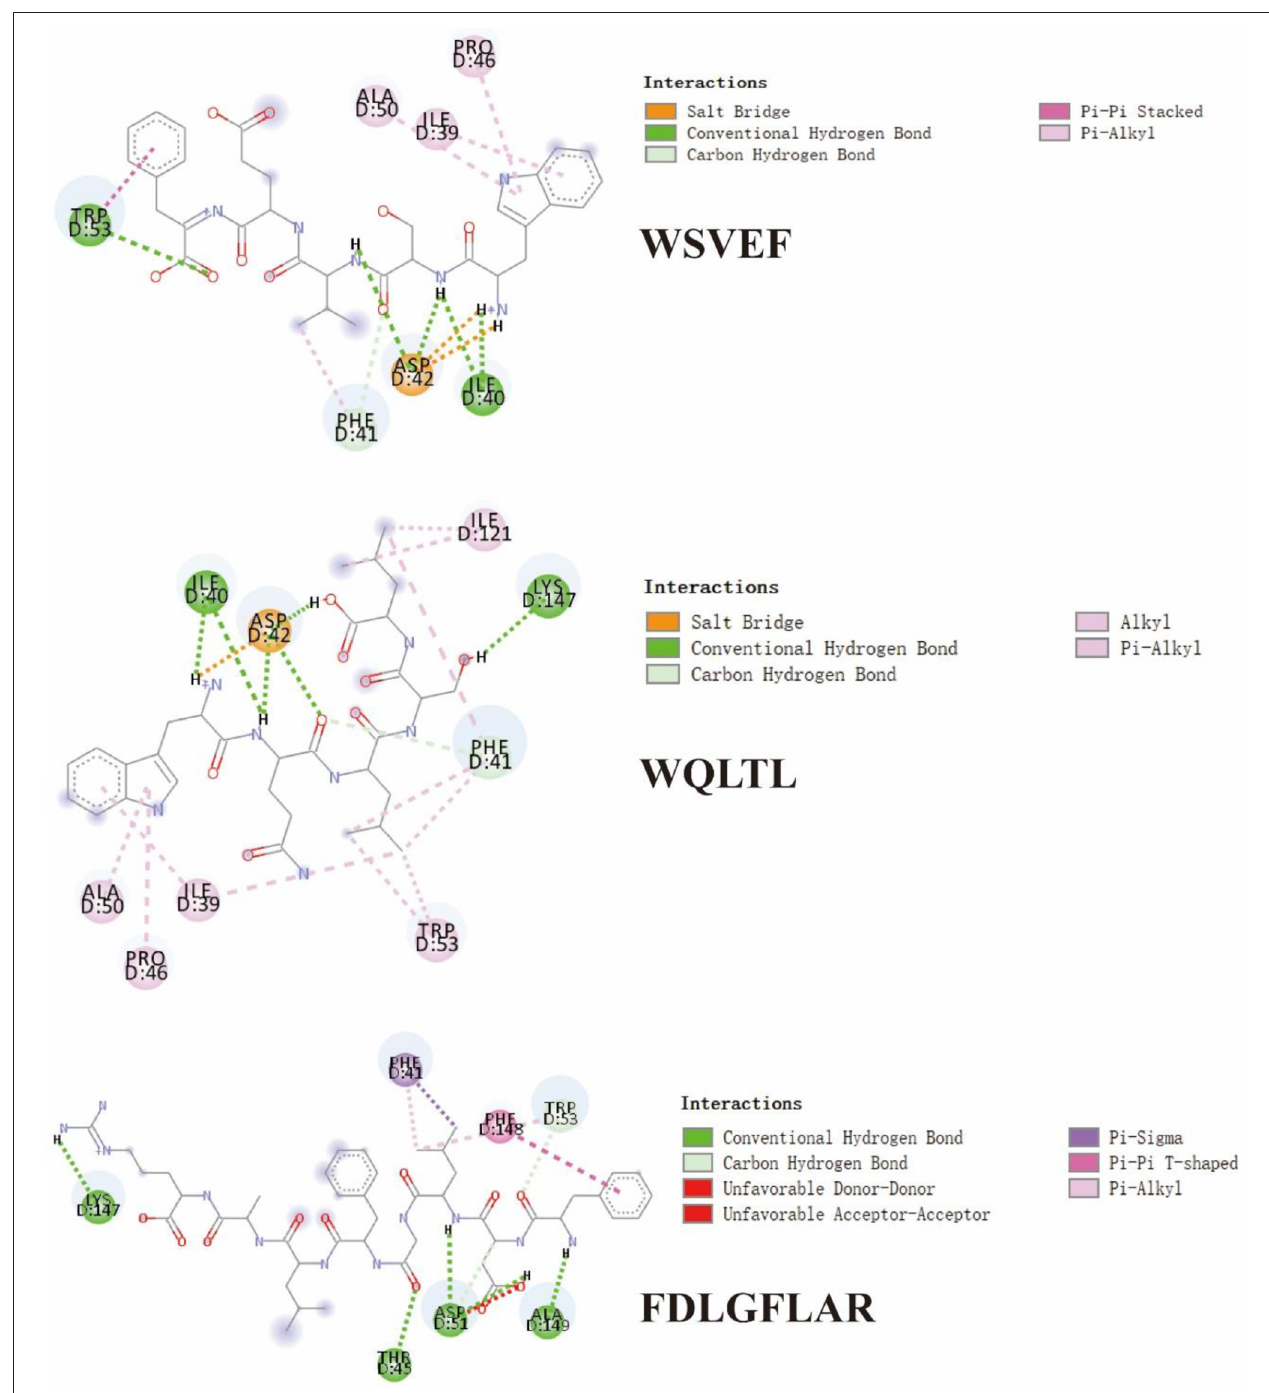
FIGURE 6 | 2D diagram showing interactions between TYIPs and tyrosinase amino acid residue.